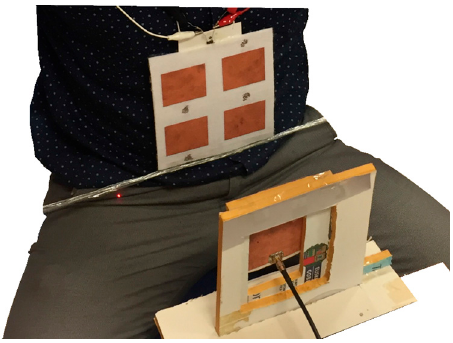
Figure 17. On-body measurement setup.